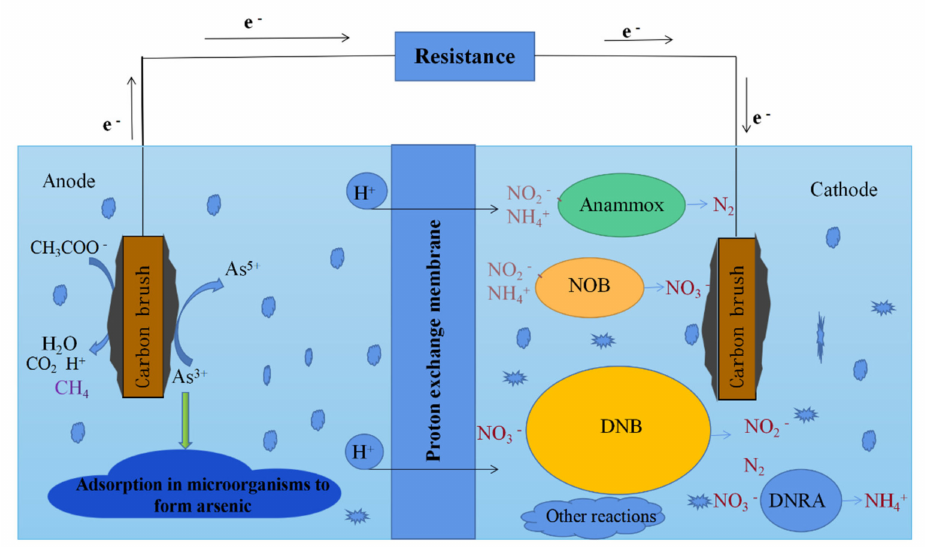
Figure 8. Speculation on the reaction mechanism of simultaneous degradation of As(III) and nitrate by